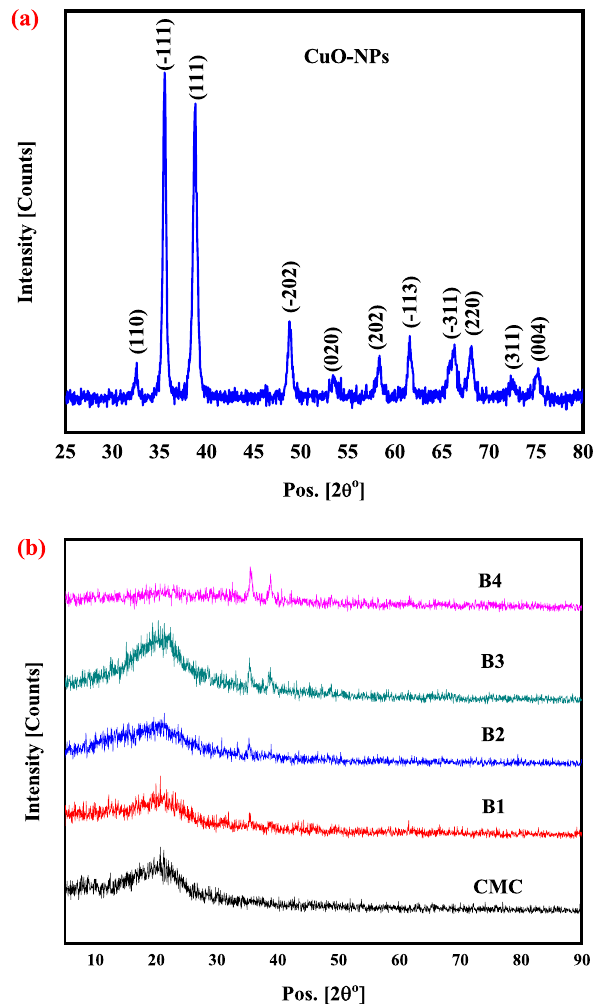
Figure 1. X-ray diffraction pattern of: ( a ) CuO-NPs and ( b ) CMC nanocomposite films including various CuO-NPs concentrations (0, 2, 4, 6 and 8 wt. %).